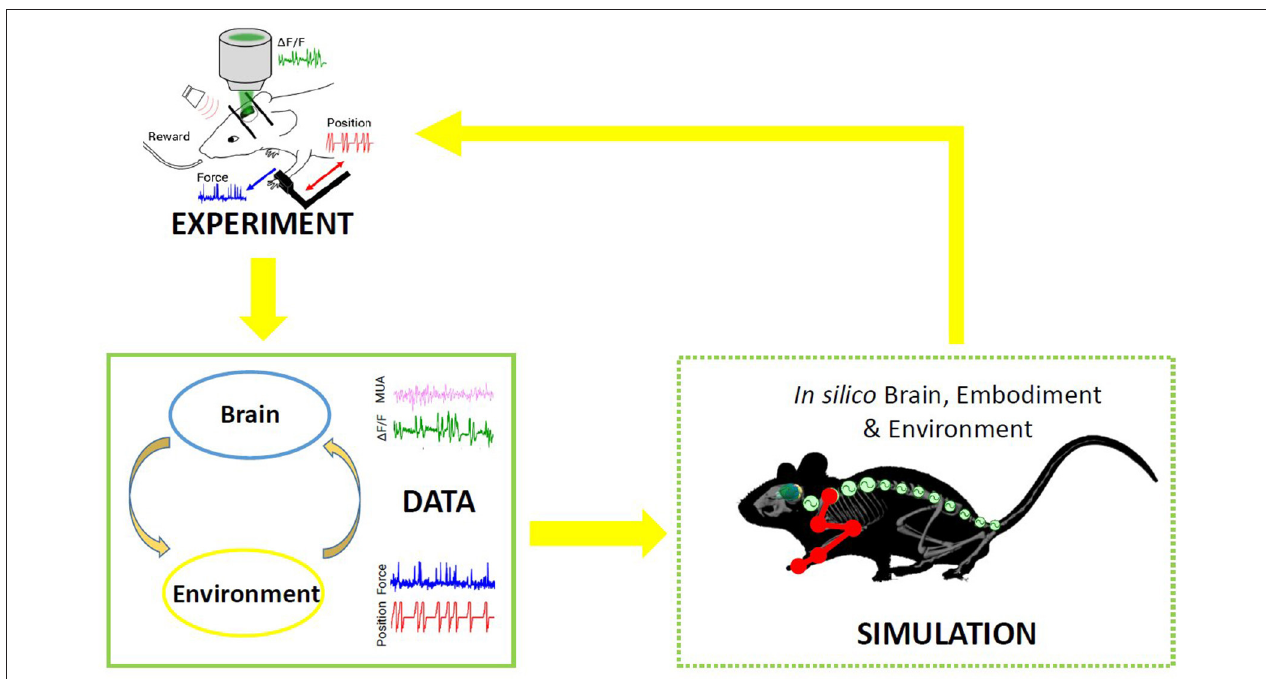
FIGURE 1 | Scheme of the proposed Embodied brain framework. The picture suggests a closed-loop workflow linking real and simulated experiment. The different types of data obtained from the experiments, from brain activity to dynamic and kinematics of goal-directed movement, are used to feed the whole brain and spinal cord model, in addition to the virtual mouse and environment. The loop is closed by validation of in silico results on real data. Eventually, the simulated experiment raises novel hypotheses, to be validated on new real